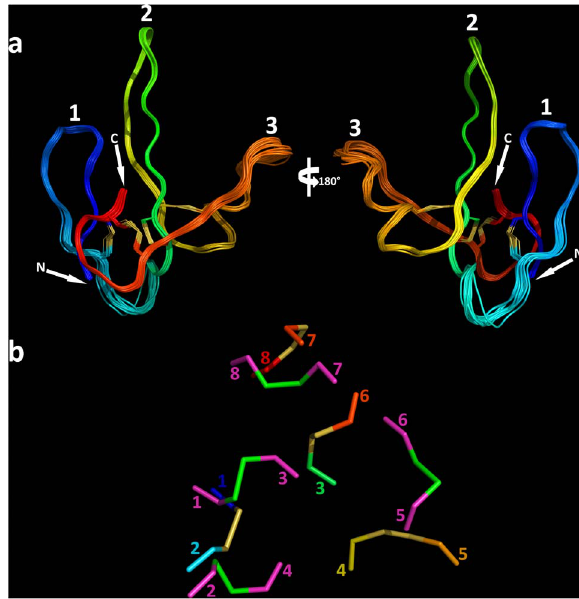
Figure 2. NMR-derived structural ensemble of PMF-G. (a) Backbone model of PMF-G with the twenty lowest-energy conformers, color coded from N- to C-terminus (blue to red), and peptide finger numbers denoted (1–3); (b) disulfide bonds in PMF-G from underside view (same color scheme as a) and a representative TFP (1IQ9, carbons in magenta, sulfurs in green).